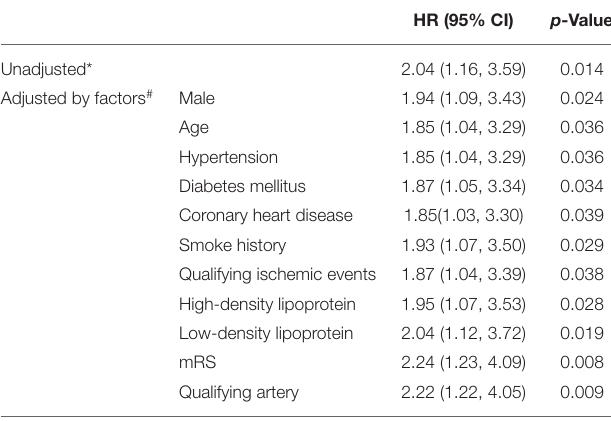
TABLE 4 | Comparison between early and delayed results in PTAS and SMT groups.